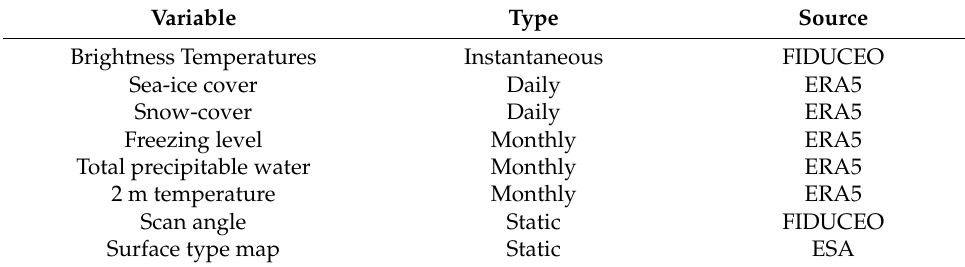
Table 2. PNPR-CLIM input